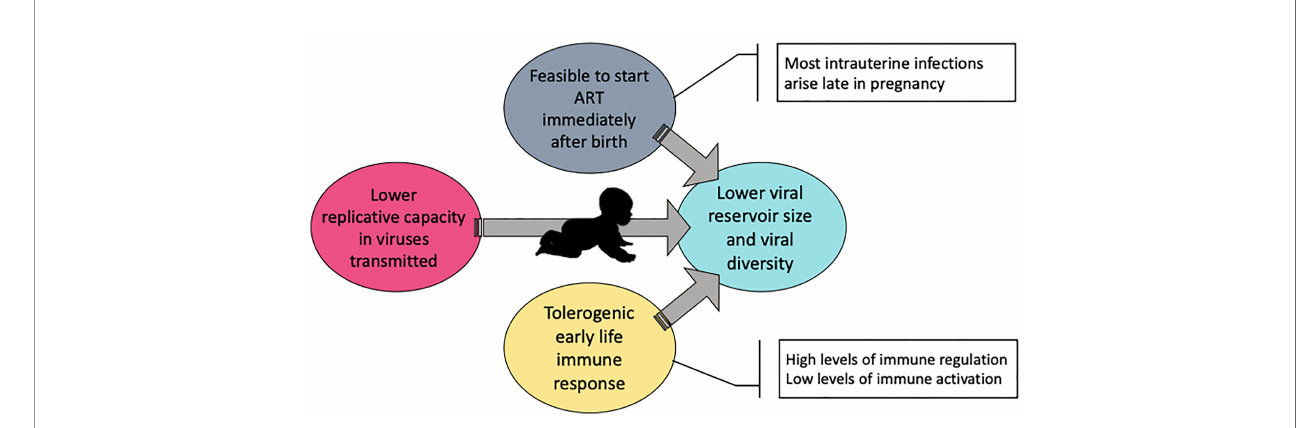
FIGURE 1 | Key factors contributing to increased HIV cure potential in children